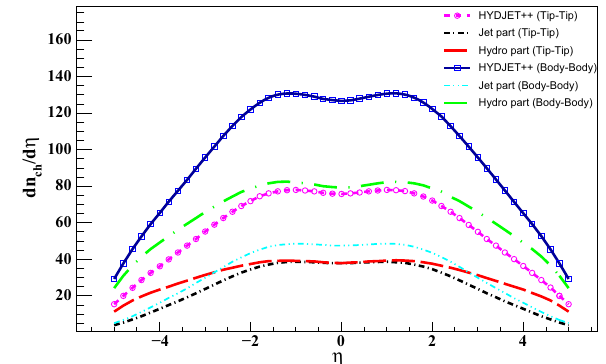
Fig. 12 Comparison of pseudorapidity distribution in tip–tip and body–body configuration for most peripheral collisions to η in tip–tip collisions of uranium nuclei at GeV. We have obtained these variations in various